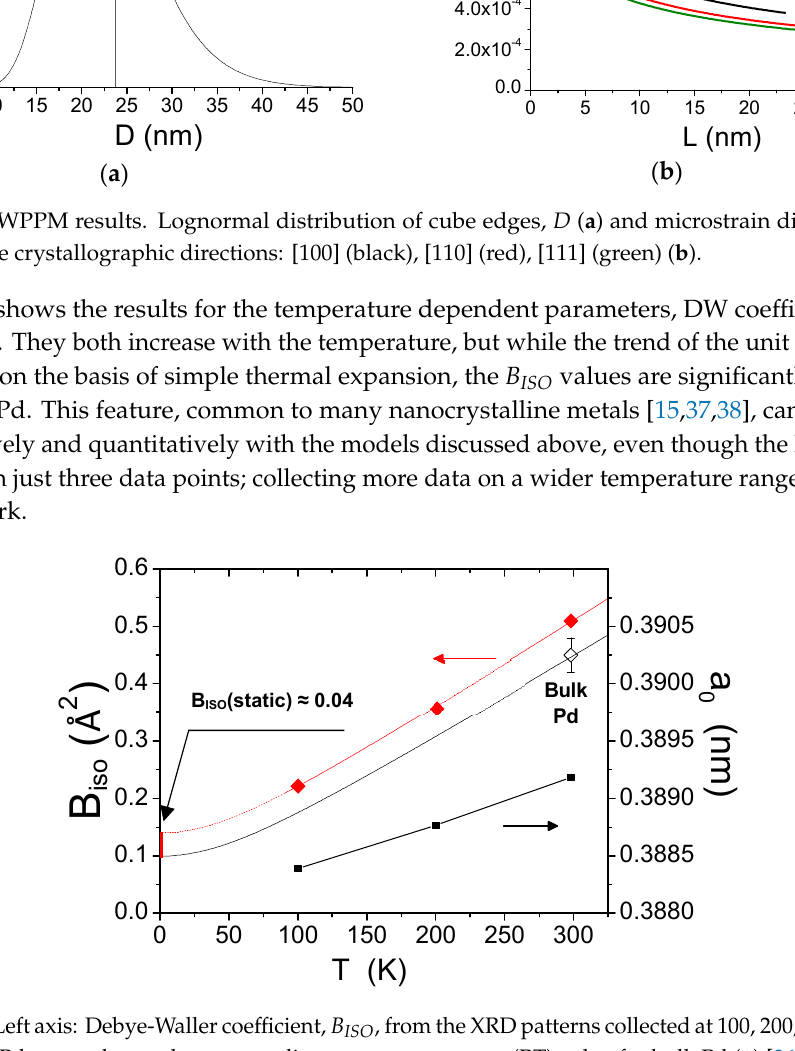
Figure 7. Left axis: Debye-Waller coefficient, B ISO , from the XRD patterns collected at 100, 200, and 300K ( ♦ ) for the Pd nanocubes and corresponding room temperature (RT) value for bulk Pd ( ) [36]. Red line is the combined model of Equation (8), black line is the extrapolation according to the Debye model for the literature bulk value. The arrow highlights the increase in the static component. Right axis: Unit cell parameter measured from the XRD patterns ( ▪ ). See text for details.